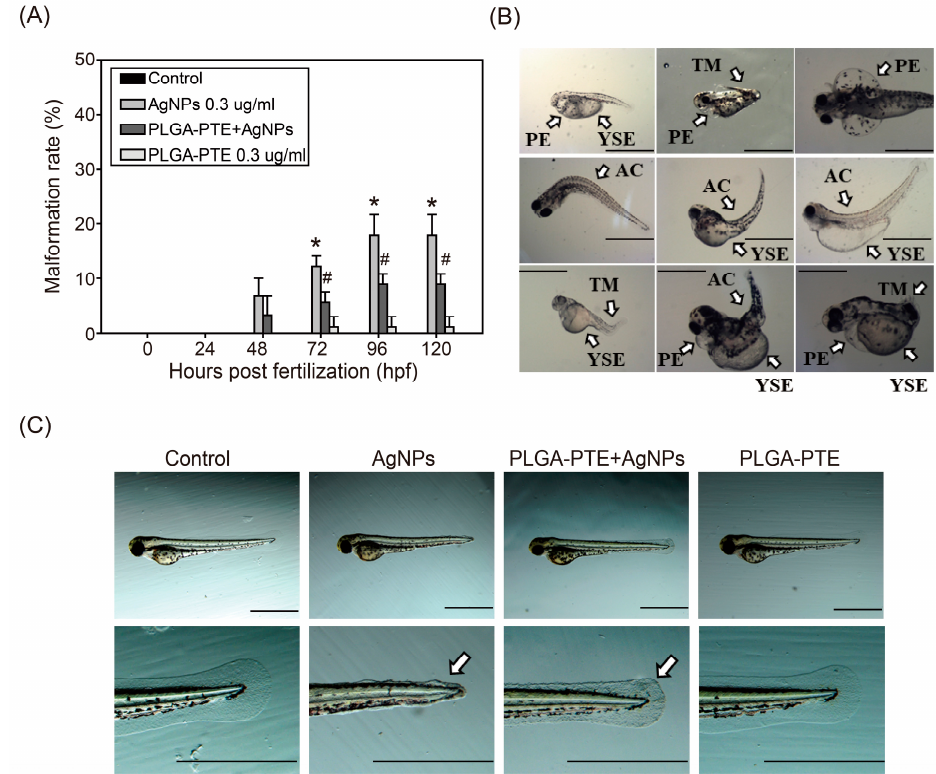
Figure 4. Malformation of zebrafish in response to treatment of AgNPs. ( A ) Malformation percentage of zebrafish embryos after exposure to control, 0.3 μ g/mL AgNPs, PLGA-PTE + AgNPs, and 0.3 μ g/mL PLGA-PTE for the indicated time points. The data are presented from at least three independent experiments ( n = 30). * p < 0.05, AgNPs groups versus control groups; # p < 0.05, PLGA- PTE + AgNPs versus AgNPs groups; ( B ) Malformations of zebrafish embryos caused by AgNPs. PE, pericardial edema; YSE, yolk sac edema; AC, axial curvature; TM, tail malformation. ( C ) Zebrafish embryos after exposure to control, 0.3 μ g/mL AgNPs, PLGA-PTE + AgNPs, and 0.3 μ g/mL PLGA-PTE for 72 hpf. White arrows showed the malformation of caudal fins. Scale bar = 1.0 mm.